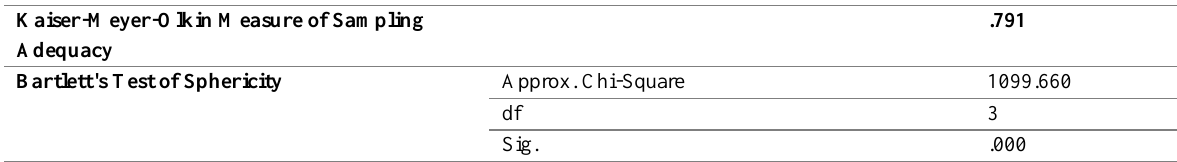
Table 8: Results.